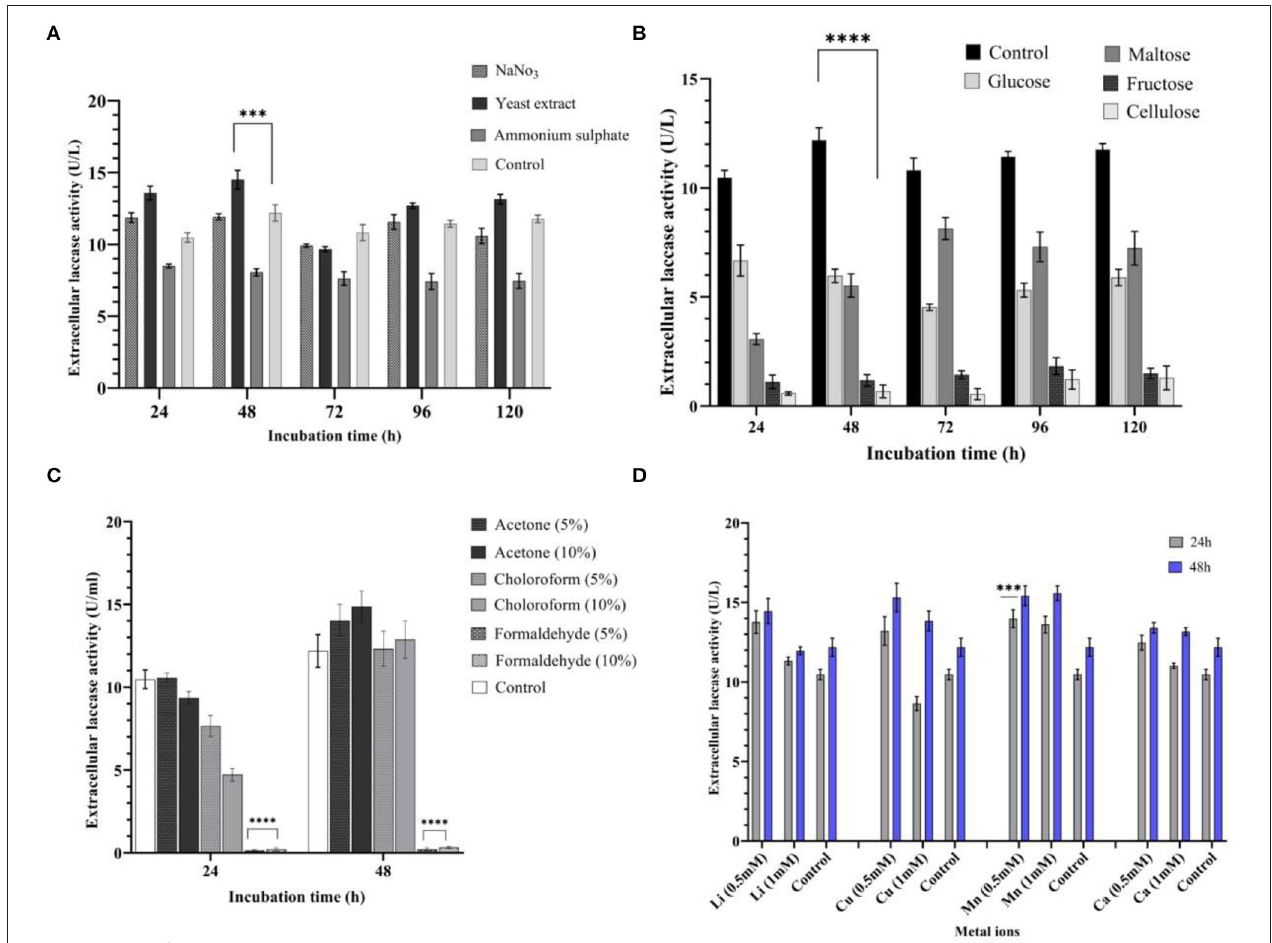
FIGURE 3 | Influence of different media variables on laccase production by strain AORB19. (A) nitrogen source; (B) carbon source; (C) organic solvents; and (D) metal ions. The four stars (****) and three stars (***) denoted the statistical significance according to the Dunnett’s multiple comparison test at P < 0.0001 and P < 0.001